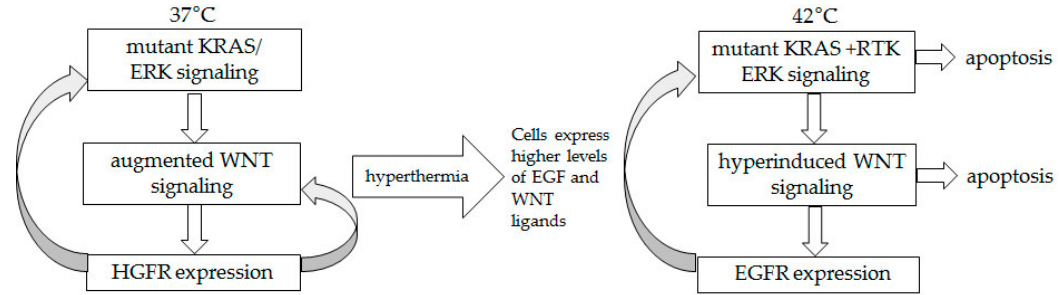
Figure 8. Proposed signaling amplifying mechanism in HCT ‐ 116 cells exposed to hyperthermia. At 37 °C, mutant KRAS supports ERK signaling, which in turn augments the already deregulated by a mutation WNT/beta ‐ catenin activity. Signaling through HGFR, a transcriptional target of WNT/beta ‐ catenin activity, feeds back positively the ERK and WNT pathways. At 42 °C, hyperthermia ‐ induced EGF and WNT ligands allow for a switch from HGFR to EGFR signaling, and to increasing in time signaling amplifying mechanism.